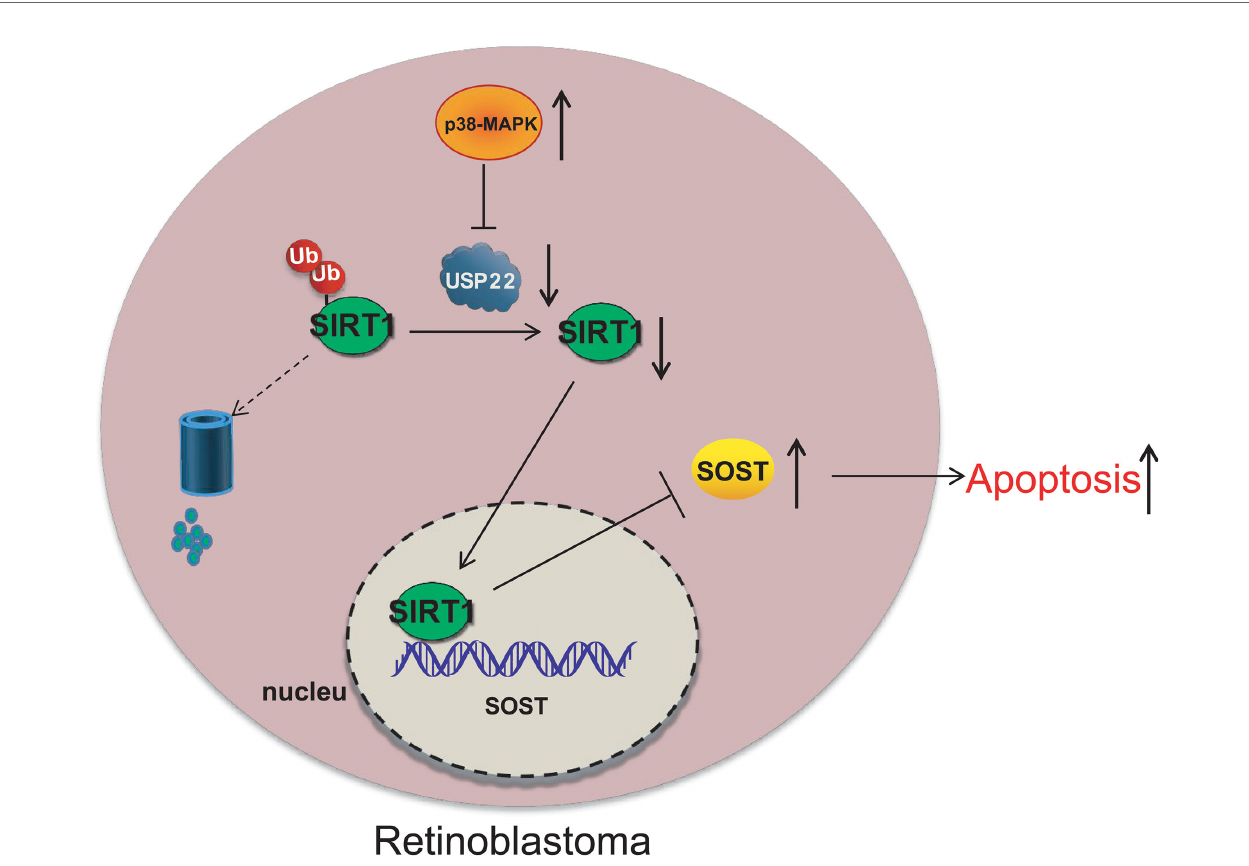
FIGURE 8 | p38 MAPK inhibits the occurrence of RB through regulating USP22 expression via SIRT1/SOST